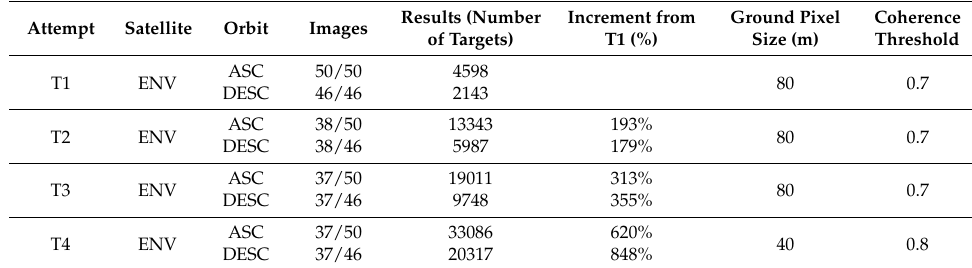
Table 2. Summary of the features of the attempts processed by the GPOD-SBAS service for the ASAR Envisat database in the VDA study area, also reporting the different values of the GPOD-SBAS processing